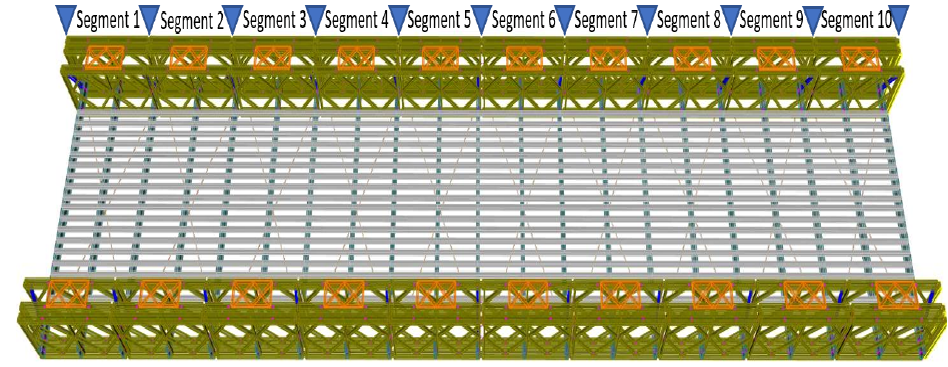
Figure 8. Bridge segments.